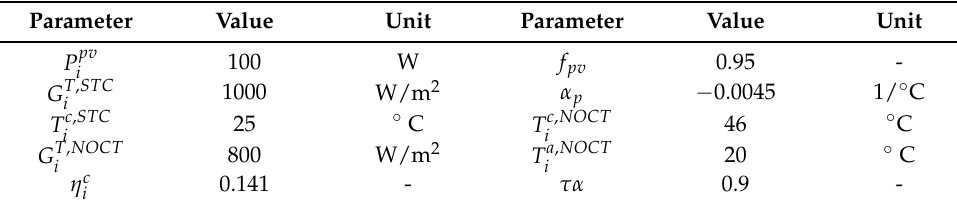
Table 4. Parametric information related to PV distributed generators.